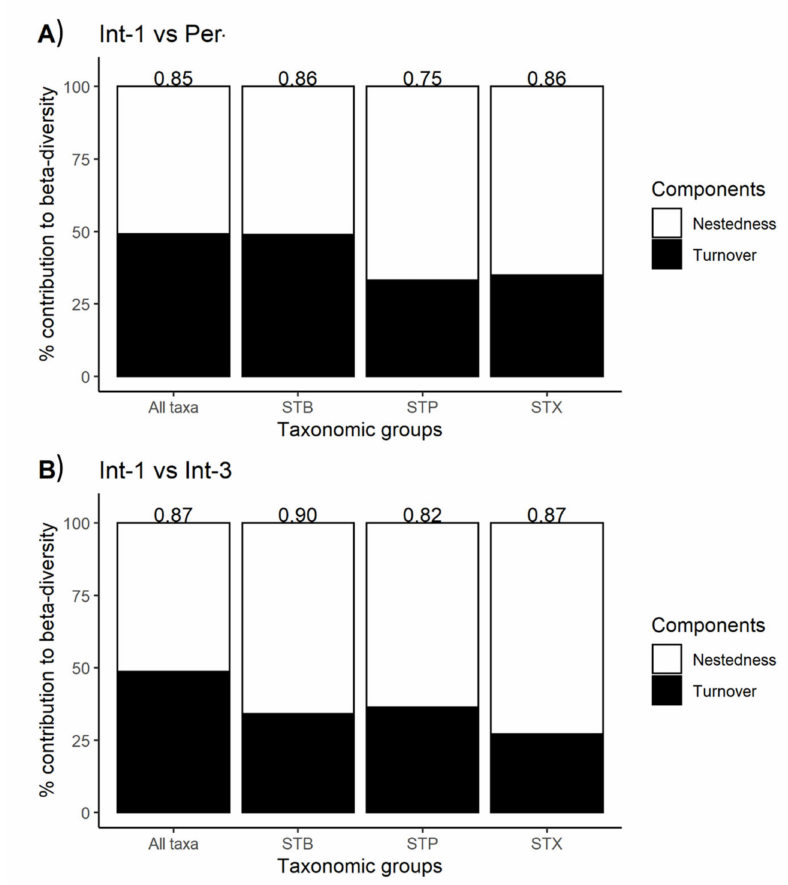
Figure 6. Mean percentage contribution of nestedness and turnover to beta-diversity in pairwise comparisons between sites: ( A ) Int -1 vs Perm-1, ( B ) Int-3 vs Int -1. Numbers above each bar indicate the total beta-diversity. STB = stygobites; STP = stygophiles; STX = stygoxenes. Numbers above each bar indicate the total beta-diversity. Station codes as in Figure